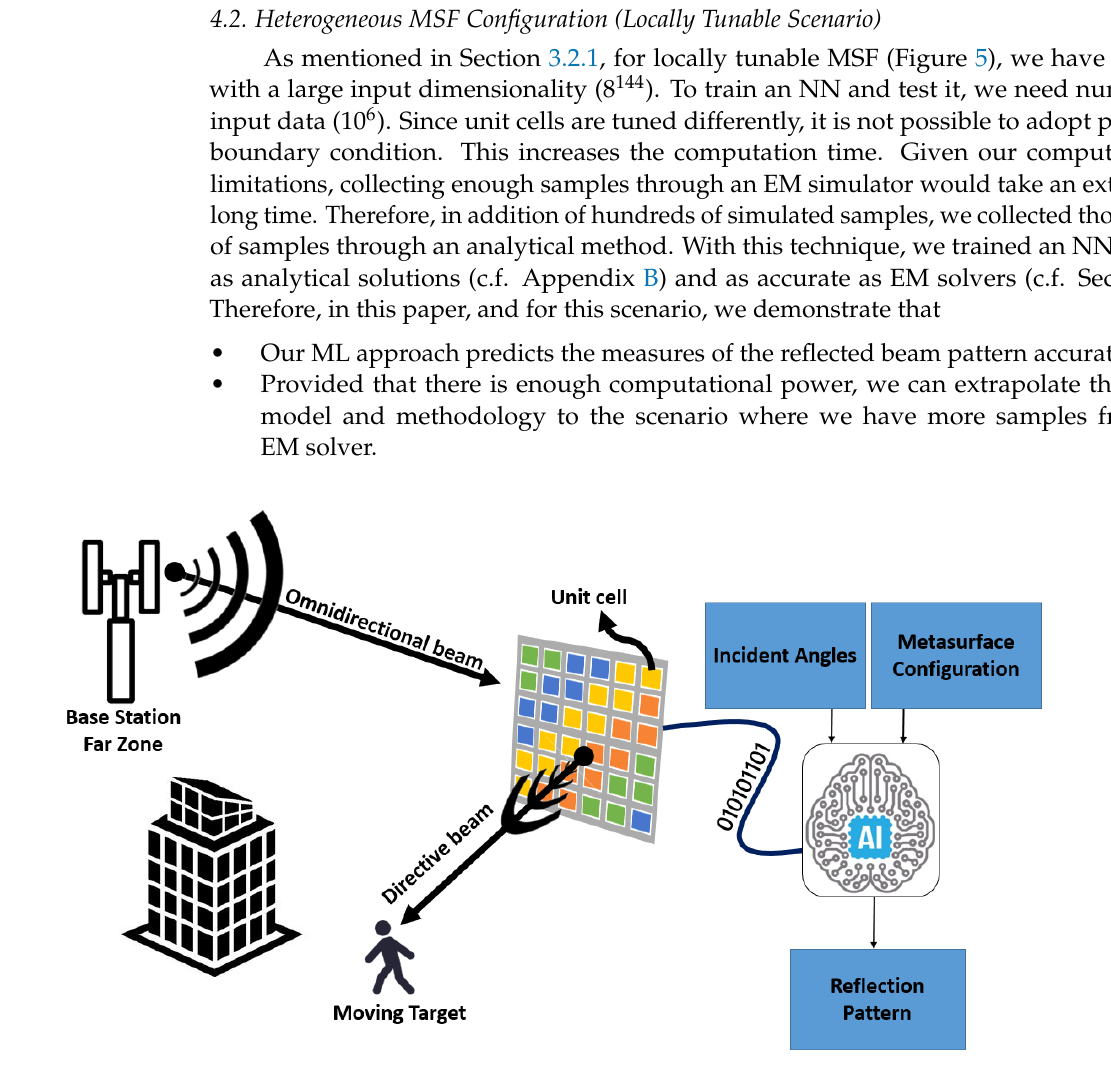
Figure 5. Graphical exhibition of the system model: Base station at the far zone radiates with an omnidirectional pattern. Planar impinging wave on the MSF reflected toward the target with a precise configuration of the MSF imposed by the well-trained